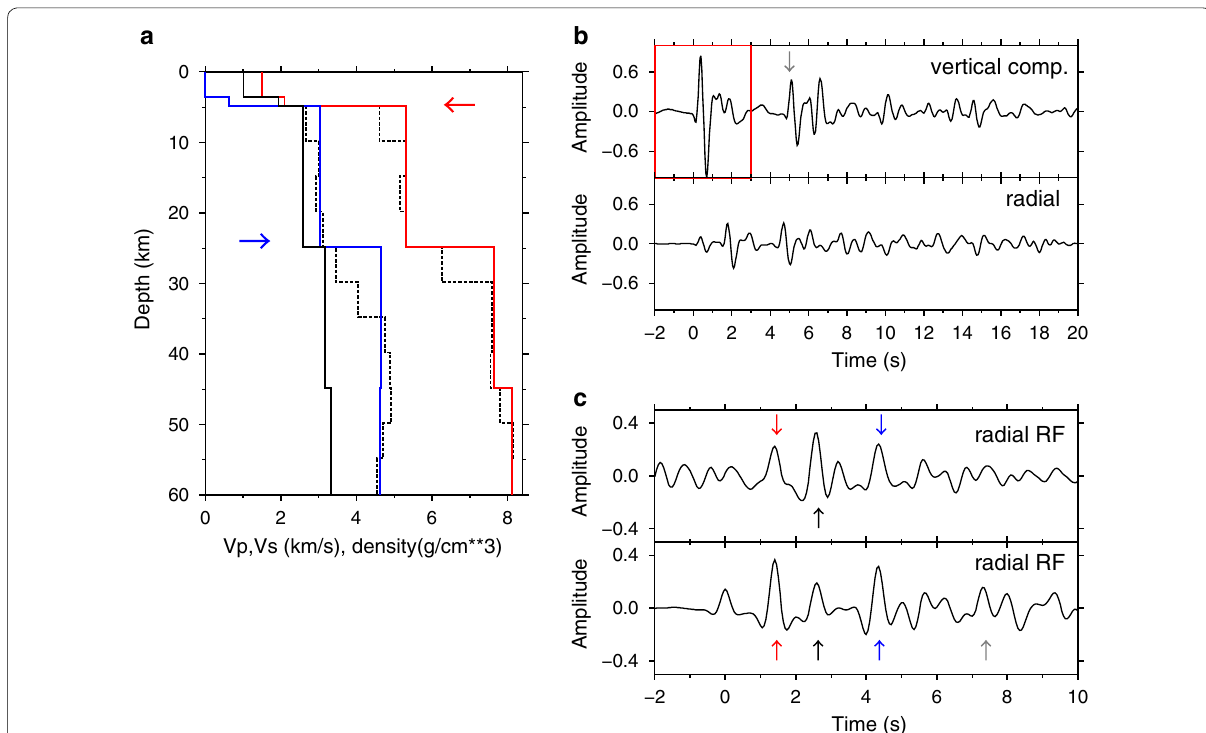
Fig. 5 Synthetic test of two time windows in the vertical component for the deconvolution. a Velocity and density models for calculating the synthetic RFs. The dashed lines indicate the P - and S -wave velocity models based on the results of the tomographic inversion at station q4. The red, blue, and black lines represent the assumed P -wave, S -wave, and density models derived from the original model (the dashed lines). The red and blue arrows show the top of the basement and the Moho of the PAC, respectively. b Synthetic waveforms in the (top) vertical and (bottom) radial components for a slowness of 0.062 s/km and at a frequency band of 0.5–2.0 Hz. The waveform in the red box was used for the deconvolution to calculate the RF at the bottom of panel ( c ). The peak indicated by the gray arrow is produced by PwP (reflected- P wave from sea surface). c Radial RFs using (top) a time window from 2 to 20 s in the vertical component and (bottom) a time window from 2 to 3 s in the vertical component. − − The peaks indicated by the red and blue arrows are produced by the subseafloor boundaries indicated by the top of the basement and the Moho of the PAC, respectively, which are indicated by the red and blue arrows in a . The peak indicated by the black arrow is produced by PsSs (multiple reflections in the sediment). The peak indicated by the gray arrow is produced by PwPs (multiple reflections caused by a seawater